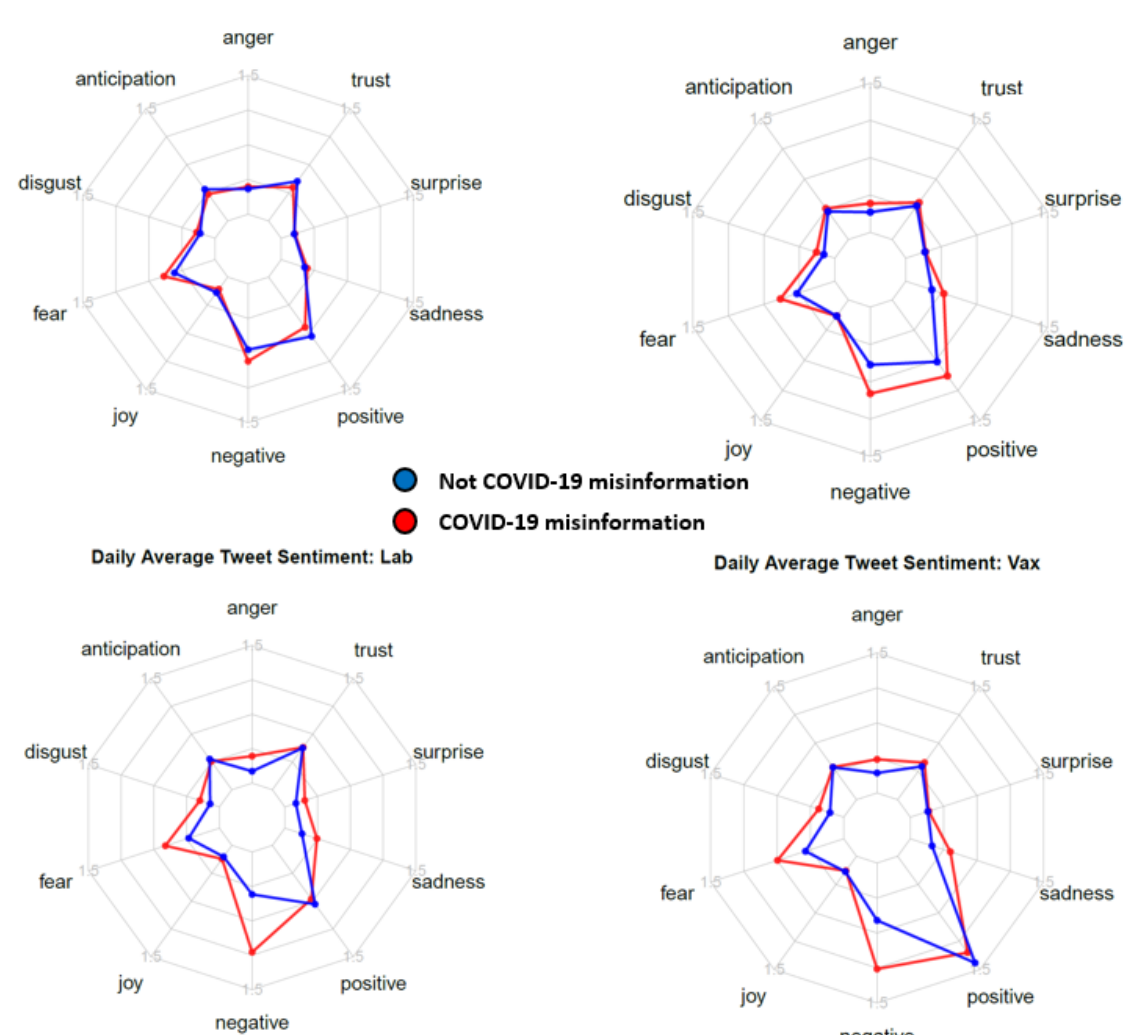
Figure 5. Sentiment comparison for each conspiracy theory by classification. The average numbers of words per tweet flagged for each sentiment category are plotted. 5G: conspiracy theories related to 5G technology; Gates: conspiracy theories related to Bill Gates or the Bill & Melinda